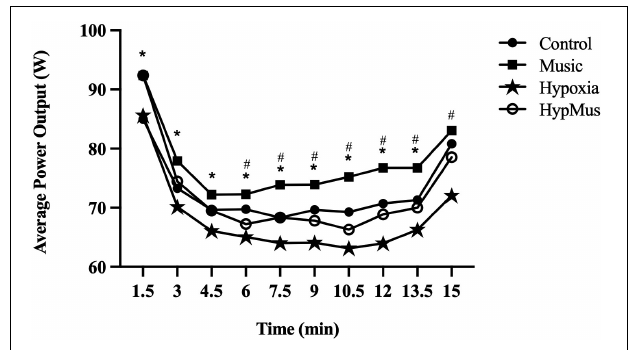
FIGURE 3 | Pacing strategies across the four main experimental trials. *Main effect of music. # Main effect of hypoxia.